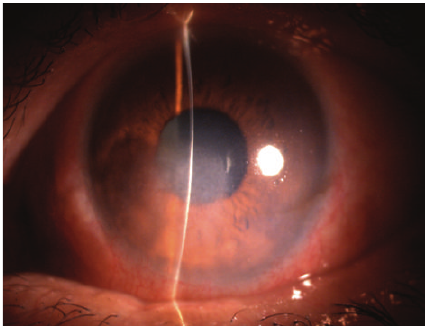
Figure 6: Day 29 since initial examination (Day 18 on Voricona-